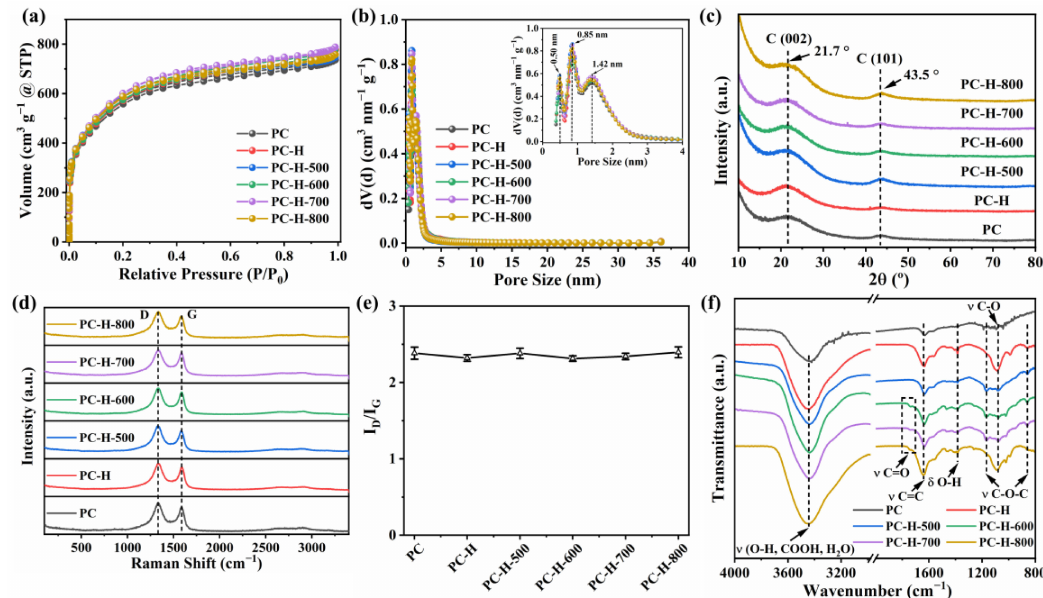
Figure 2. ( a ) Ar adsorption–desorption isotherms, ( b ) pore size distribution curves, ( c ) XRD patterns, ( d ) Raman spectra, ( e ) I D /I G ratios, and ( f ) FTIR spectra of PC, PC-H, PC-H-500, PC-H-600, PC-H-700, and PC-H-800 supports. Table 1. Textural parameters of PC, PC-H, PC-H-500, PC-H-600, PC-H-700, and PC-H-800 supports.